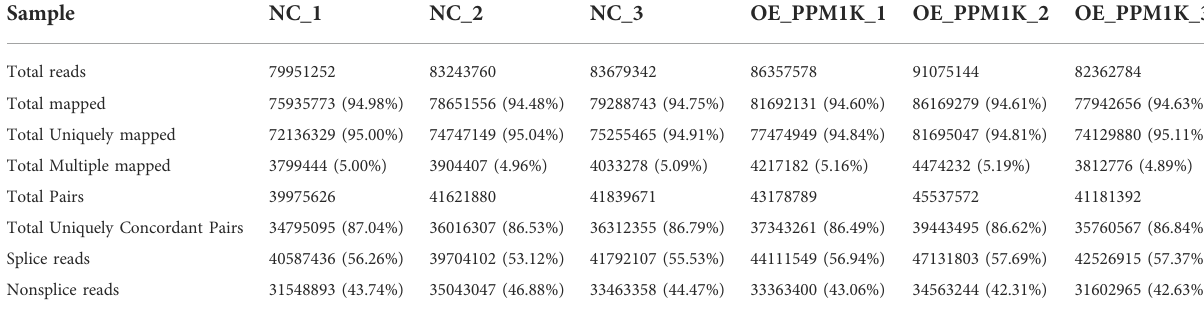
TABLE 2 Mapping of clean reads on the reference genome.